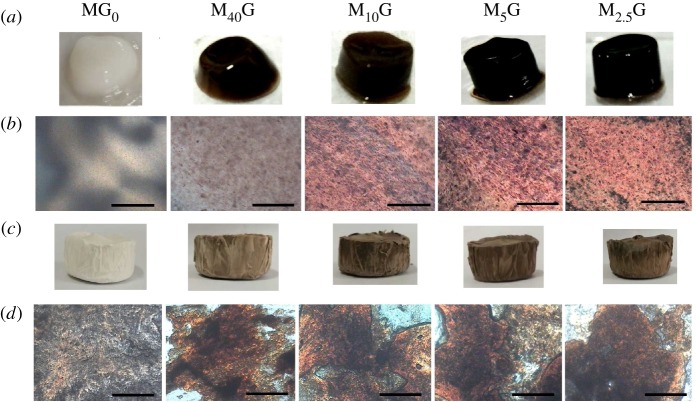
Digital photos of the gels (a). POM images of the corresponding gels (b). Digital photos of the corresponding aerogels (c). POM images of the corresponding aerogels (d). All the images from left to right in order: MG0, M40G, M10G, M5G, M2.5G. Scale bar, 400 µm.